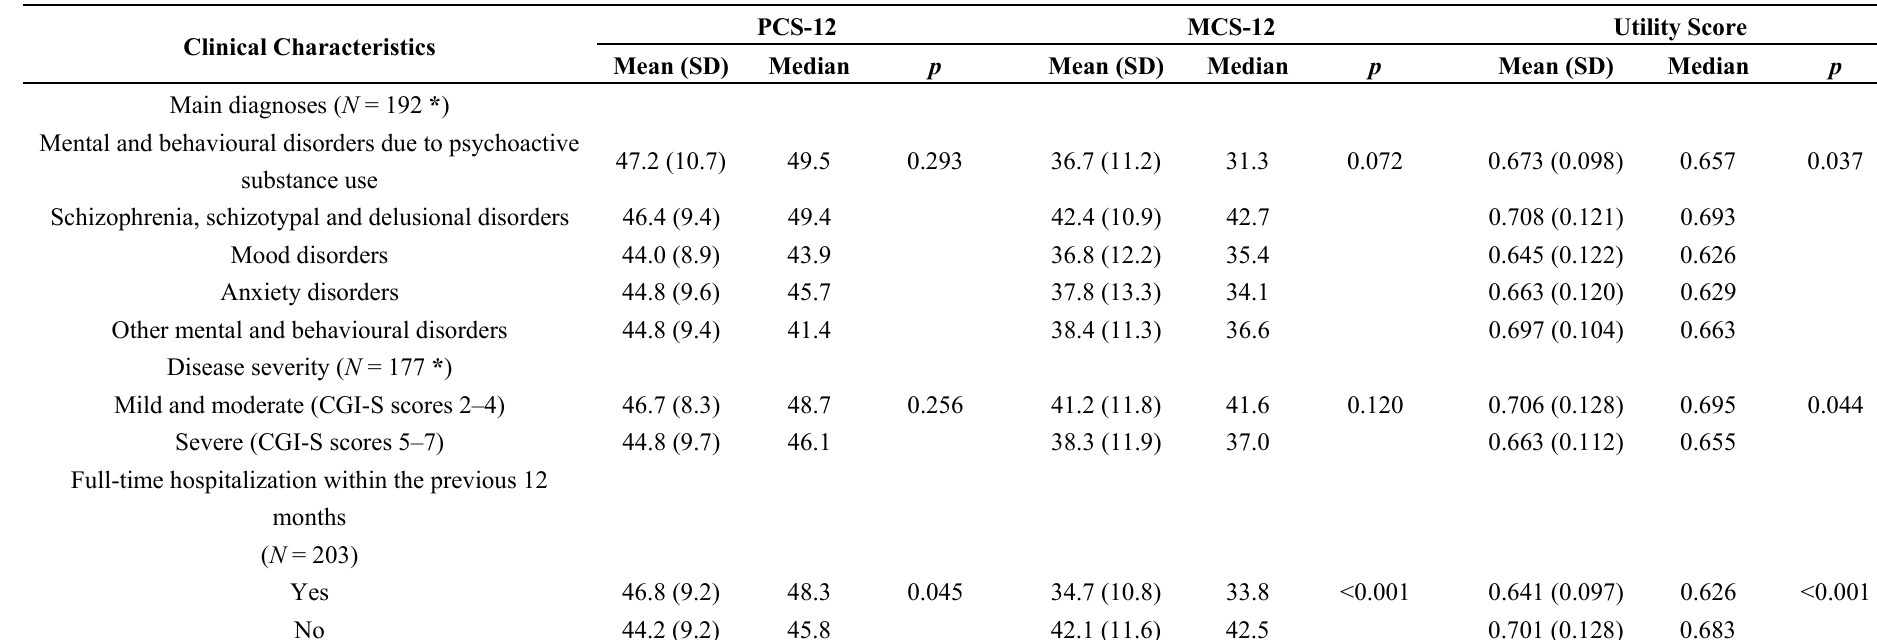
Table 3. HRQoL and utility scores in the Patient-MD group by clinical